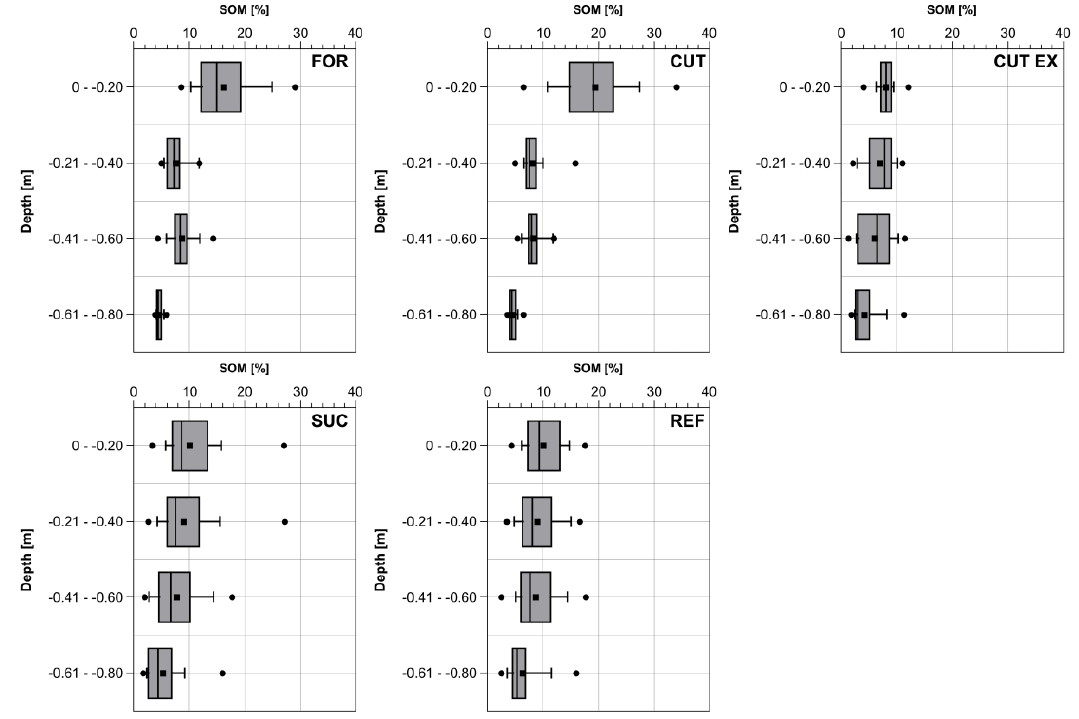
Figure 8. Soil organic matter (SOM) dataset distribution. Table 6. Mean soil organic matter (SOM) content. Depth aggregated data. Mean SOM [%] Depth [m] FOR CUT CUT EX SUC